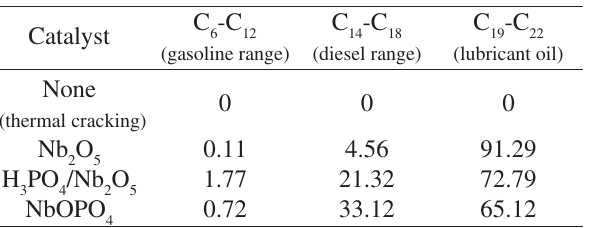
Table 4. Products distribution expressed in hydrocarbon ranges (weight